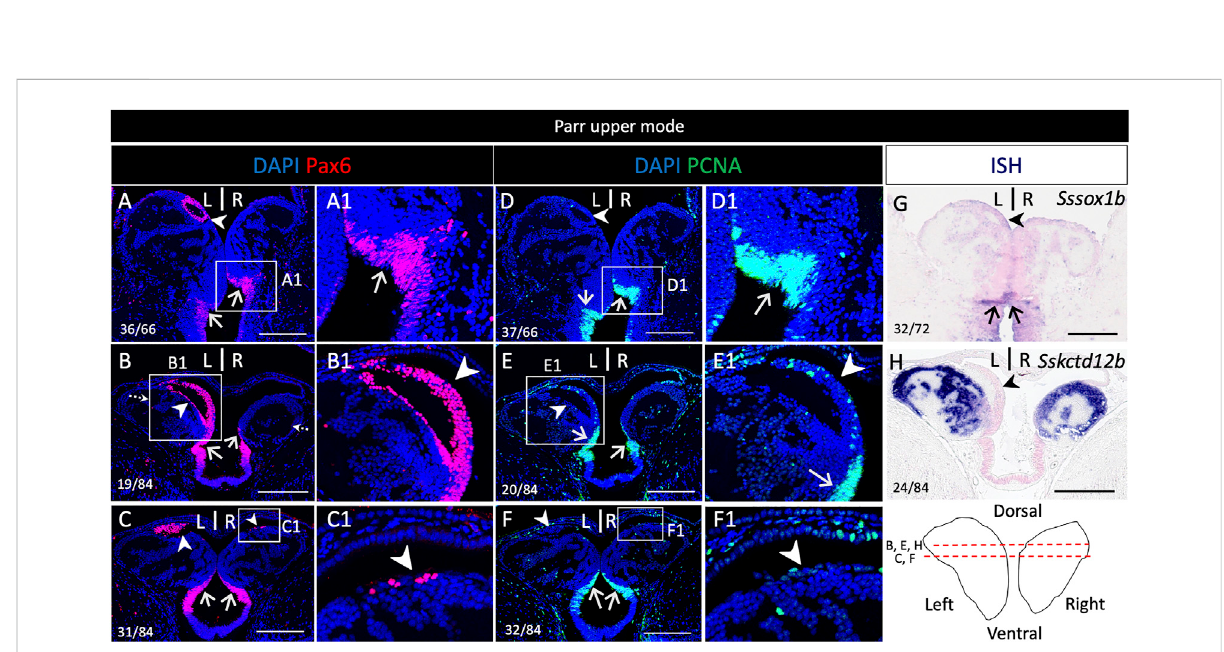
FIGURE 4 Pax6 expression in neural progenitors and a dorsal neuronal territory in the habenulae of Atlantic salmon. (A – H) show sections of a parr upper mode following IHC using antibodies directed against pax6 (A – C) , PCNA (D – F) and following ISH using probes for Sssox1b (G) and Sskctd12b (H) . (A,D,G) are transverse sections at the level indicated by dotted arrows in (B) , (B – C,E,F,H ) are horizontal sections at the level indicated by red lines on the front view of habenulae schematized in the bottom right panel. (A1 – F1) are higher magni fi cation views of the territories boxed in (A – F) . Arrowheads point towards the left-restricted dorsal nucleus and a smaller, right-sided, dorsal population of clustered cells positive for pax6 but negative for PCNA. Thin arrows point towards posterior and ventral neural progenitors. Same abbreviations as in Figure 1. Scale bars = 200 μ m.